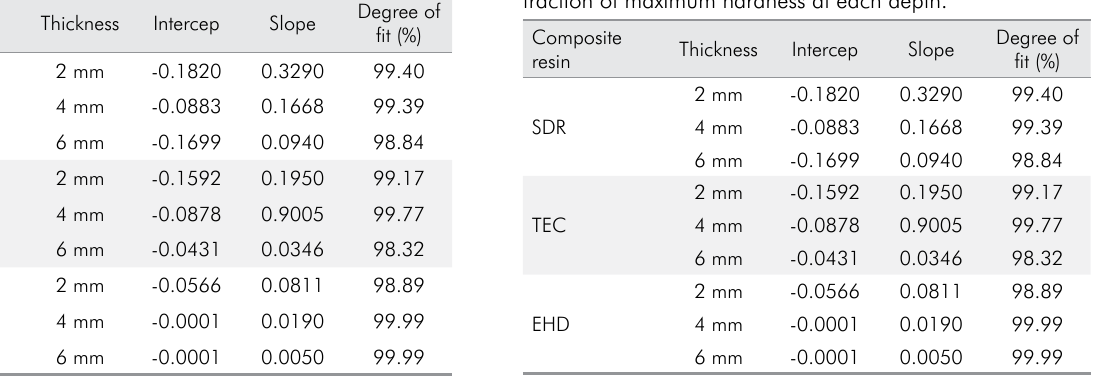
Table 4. Estimated time required in seconds to deliver radiant